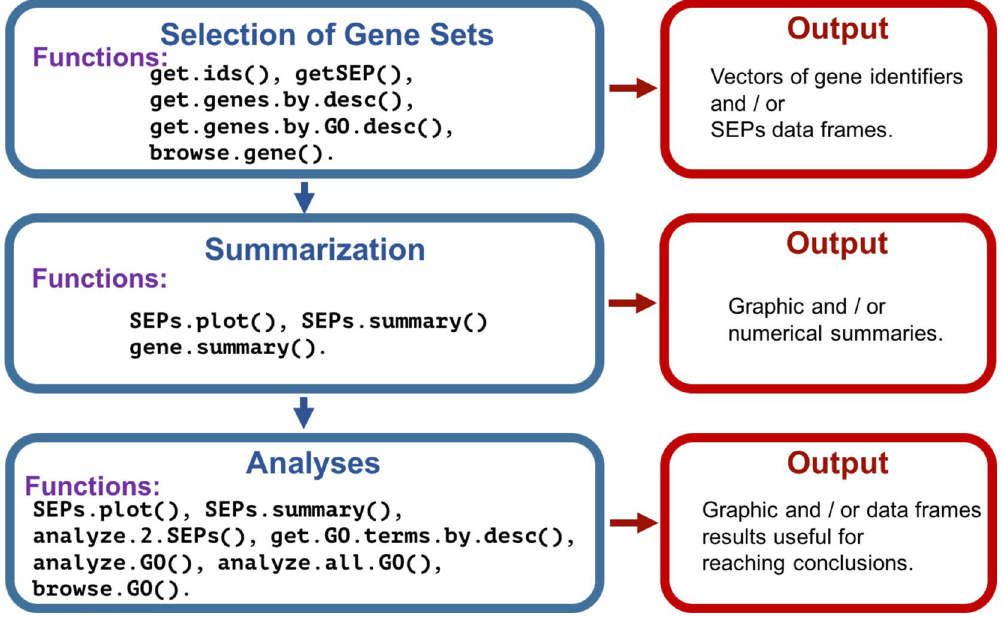
Figure 2. Simplified schema of data mining workflow in Salsa. Comprehensive description of the output of each one of the functions, as well as details for their use are presented in Additional file 1 as well as in the Salsa package